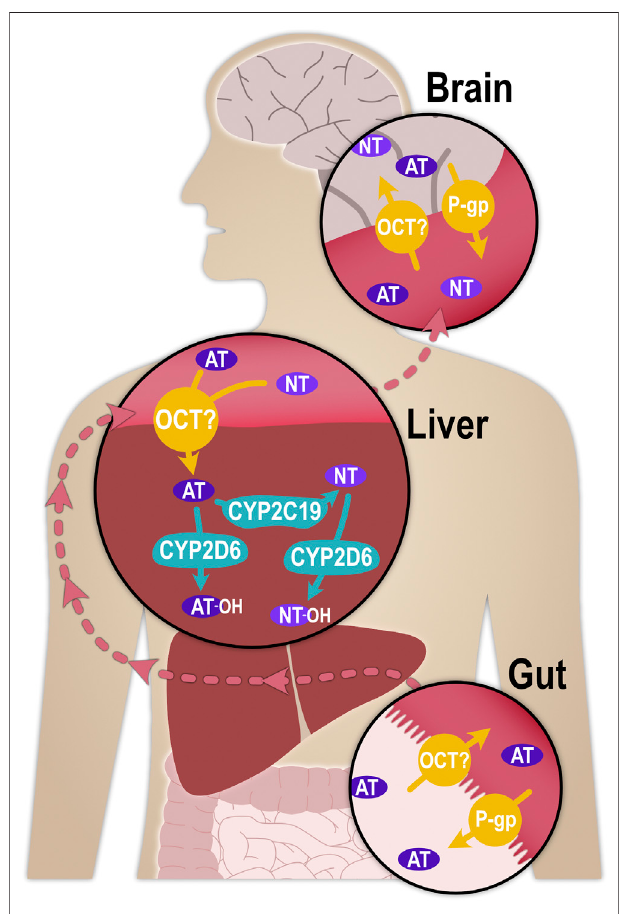
FIGURE 1 | Schematic illustration of the processes that determine the pharmacokinetics of AT and NT. P-glycoprotein (P-gp, MDR1, ABCB1), as part of the blood-brain-barrier, was shown in mice to transport AT and NT from the central nervous system into brain capillaries, thereby determining their concentrations at the synapse (Uhr, 2000; Grauer and Uhr, 2004; Uhr et al., 2007).